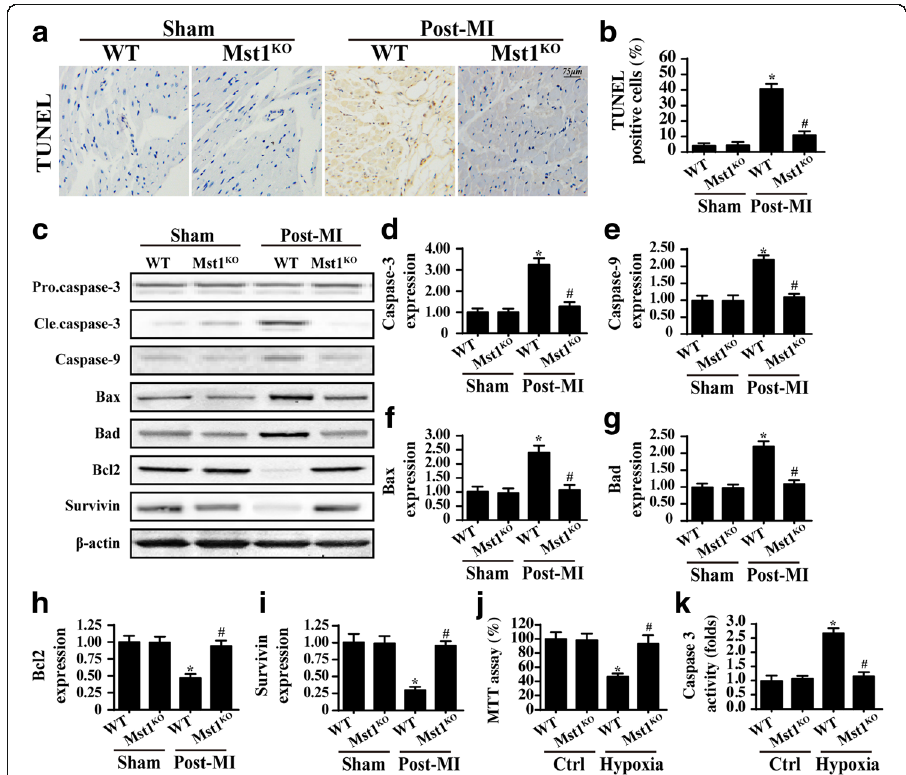
Fig. 3 Mst1 promoted cardiomyocyte death in the heart after a myocardial infarction (MI). a and b The TUNEL assay was used to observe cellular apoptosis in vivo in wild-type (WT) and Mst1-knockout (Mst1 KO ) cells. c – i The mitochondrial apoptotic proteins pro-caspase-3, cleaved caspase-3 (Cle.caspase-3), caspase-9, Bax, Bad, Bcl2, survivin and β -actin were measured via western blots. Mst1 elevated mitochondrial apoptotic protein levels in the post-infarcted heart. j and k Cardiomyocytes were isolated from WT and Mst1 KO mice and a hypoxia model was used to induce cardiomyocyte damage in vitro. The MTT and caspase-3 activity assays were used to assess cellular viability * p < 0.05 vs. sham group, # p < 0.05 vs. WT mice in post-MI